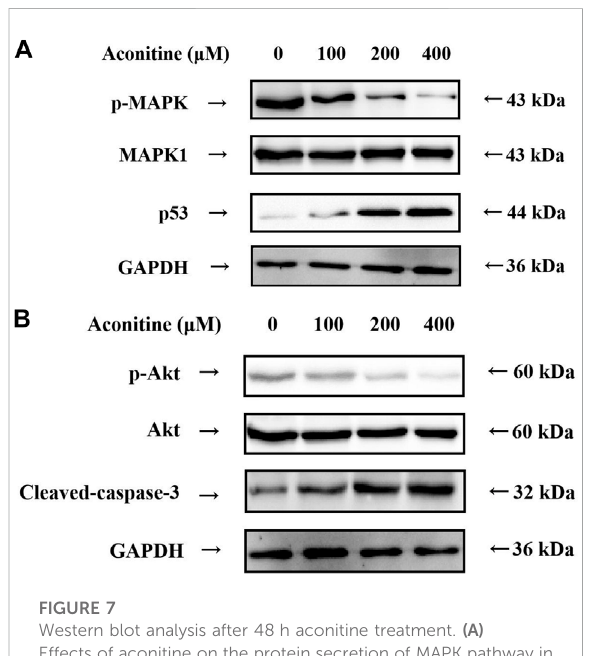
FIGURE 7 Western blot analysis after 48 h aconitine treatment. (A) Effects of aconitine on the protein secretion of MAPK pathway in SH-SY5Y cells. (B) Effects of aconitine on the secretory levels of p-Akt, Akt and Cleaved-caspase-3 in SH-SY5Y